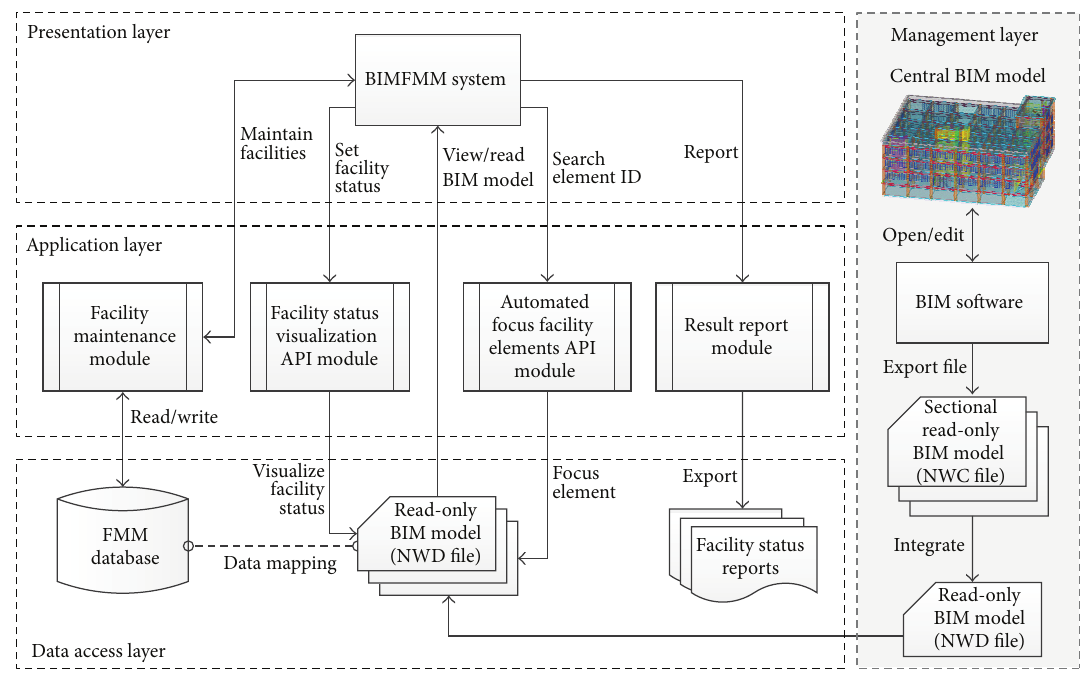
Figure 2: System and module framework of the BIMFMM